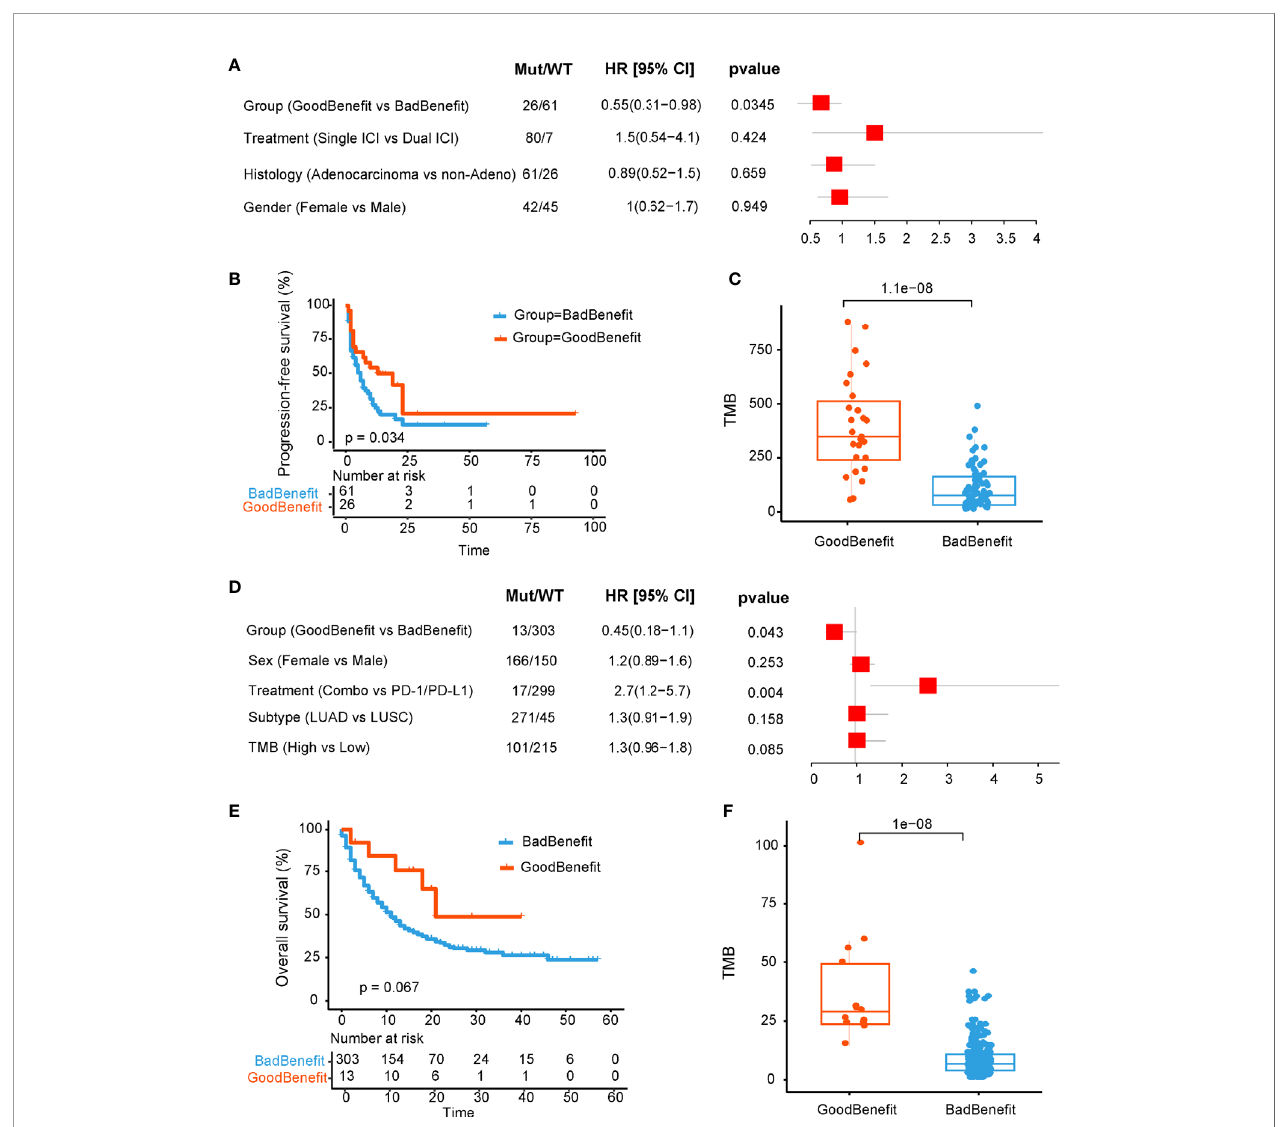
FIGURE 3 | Validation of NOTCH/co-DDR co-occurring pathways to ICI ef fi cacy in Anagnostou et al. cohort (A – C) and MSKCC cohort (D – F) . (A) Forest plot displaying univariate cox regression analyses for PFS of individually considered pathway for Anagnostou et al. dataset. (B) Kaplan-Meier survival curves for PFS comparing “ GoodBene fi t ” versus “ BadBene fi t. ” (C) Boxplot of TMB in “ GoodBene fi t ” versus “ BadBene fi t. ” (D) Forest plot displaying univariate cox regression analyses for OS of individually considered pathway for MSKCC data. (E) Kaplan-Meier survival curves for OS comparing “ GoodBene fi t ” versus “ BadBene fi t. ” (F) Boxplot of TMB in “ GoodBene fi t ” versus “ BadBene fi t.